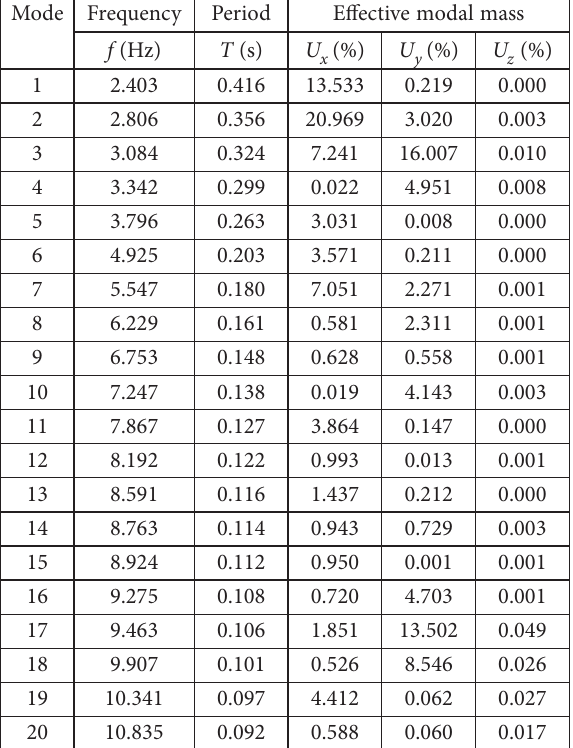
Table 5. Modal informations of the Nossa Senhora